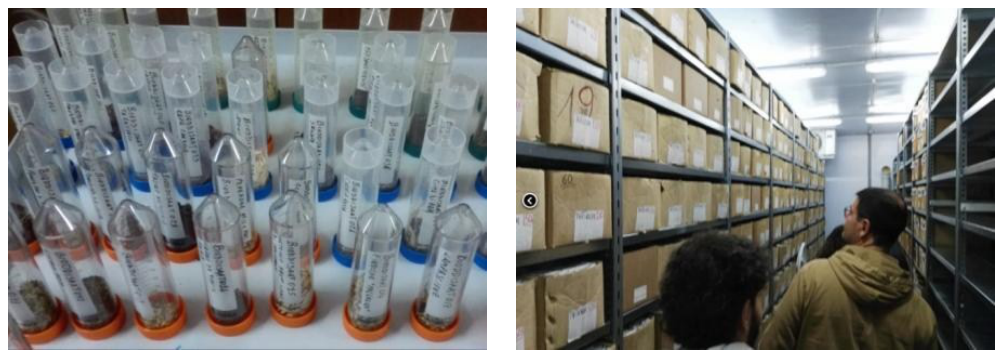
Figure 5. Example of accessions seeds ( left ) recovered to be preserved at the seed bank ( right ) of the Institute of Biosciences and Bioresources of the Italian National Research Council in Bari, Italy (Photo credit: Beniamino Leoni).